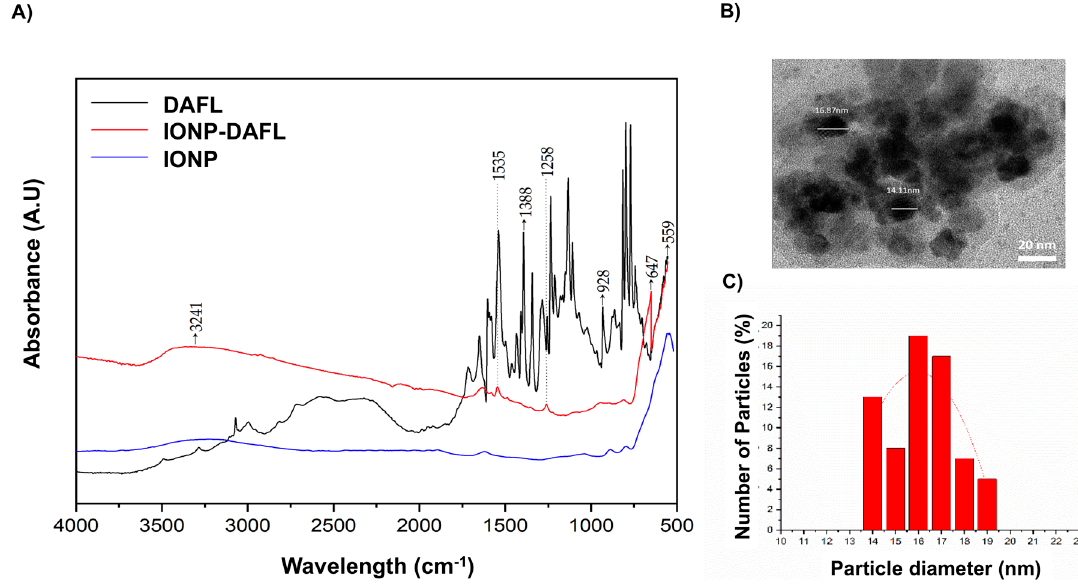
Figure 2. ( A ) The ATR-FTIR spectra of IONP-DAFL, IONP, and dopamine-flavin (DAFL). ( B ) TEM images of IONP-DAFL. ( C ) The particle size distribution determined from the average of ~100 measurements of particles.